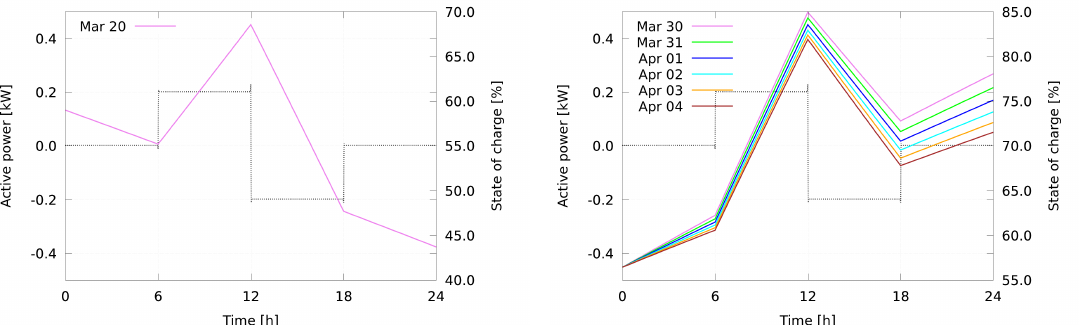
Figure 18. Evaluation of the adaptive battery storage models used on the different days of the experimental setup on a test schedule over 24 h: ( left ) first test period; and ( right ) second test period. The predicted active power is shown as dotted black line, forecasts of the state of charge as colored solid